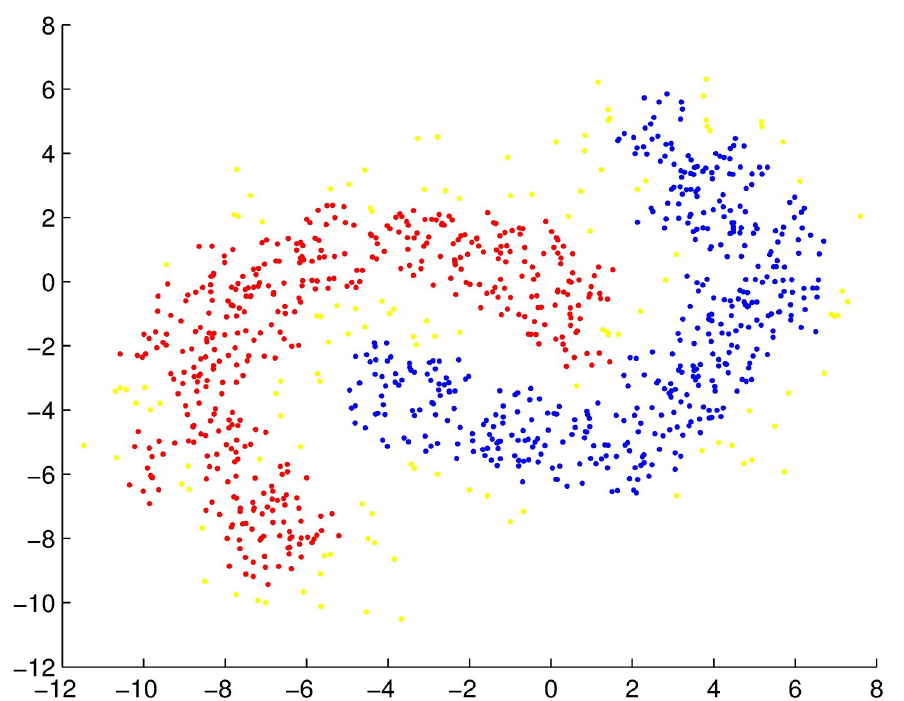
Fig 5. The 2 clusters and noise points with DBSCAN algorithm.